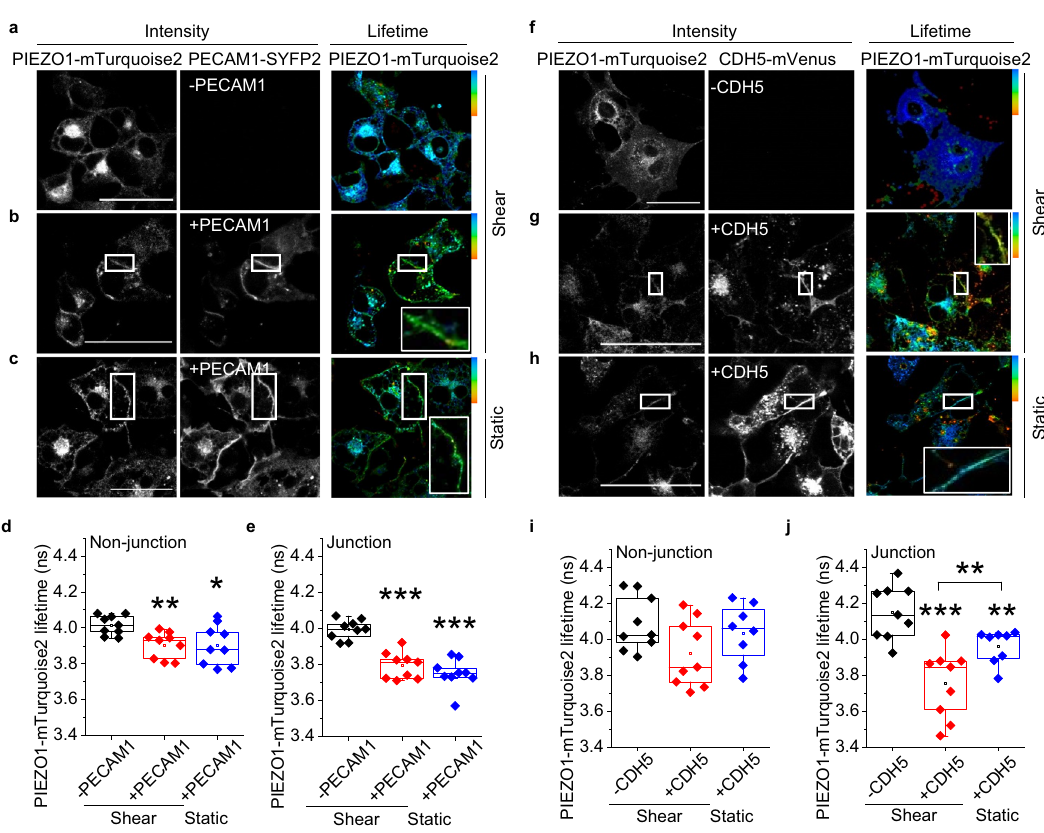
Fig. 6 CDH5 partnering is shear stress dependent. COS-7 cell data obtained by FRET/FLIM after expressing PIEZO1-mTurquoise2 with ( + ) or without ( − ): a – e PECAM1-SYFP2 (PECAM1); f – j CDH5-mVenus (CDH5). Prior to imaging, cells were preconditioned for 24 h with laminar shear stress (10 dyn.cm − 2 ) followed by static condition for 30 min and then 10 min 10 dyn.cm − 2 (shear) or continued static condition (static). For 3 independent experiments each, the box plots show the lifetimes for PIEZO1-mTurquoise2 at cell-cell junctions: e + PECAM1 *** P = 2.64 ×10 − 4 shear and *** P = 1.37 ×10 − 4 static, both compared with – PECAM1; j + CDH5 *** P = 2.63 ×10 − 4 shear and ** P = 0.0079 static, both compared with – CDH5. + CDH5 shear cf + CDH5 static ** P = 0.00036 and the lifetimes for PIEZO1-mTurquoise2 at non junctional regions: d + PECAM1 ** P = 0.0021 shear and * P = 0.011 static, both compared with – PECAM1; i + CDH5 showed no signi fi cant differences to the – CDH5 under shear and static conditions. The superimposed data points are for individual junctions ( N = 9) and non-junctions ( N = 9) from separate images. P values are from Mann – Whitney tests with Bonferroni